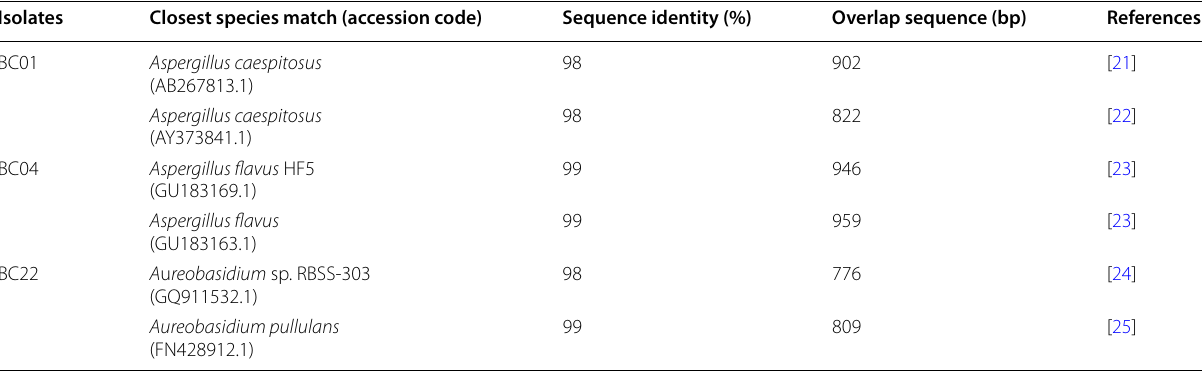
Table 2 Closest matches from BLAST searches of fungal sequences Isolates Closest species match (accession